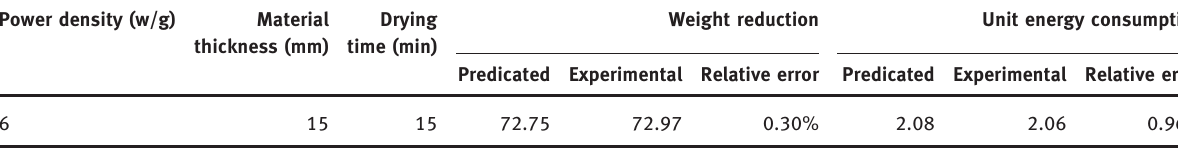
Table 4: Validation of the model.